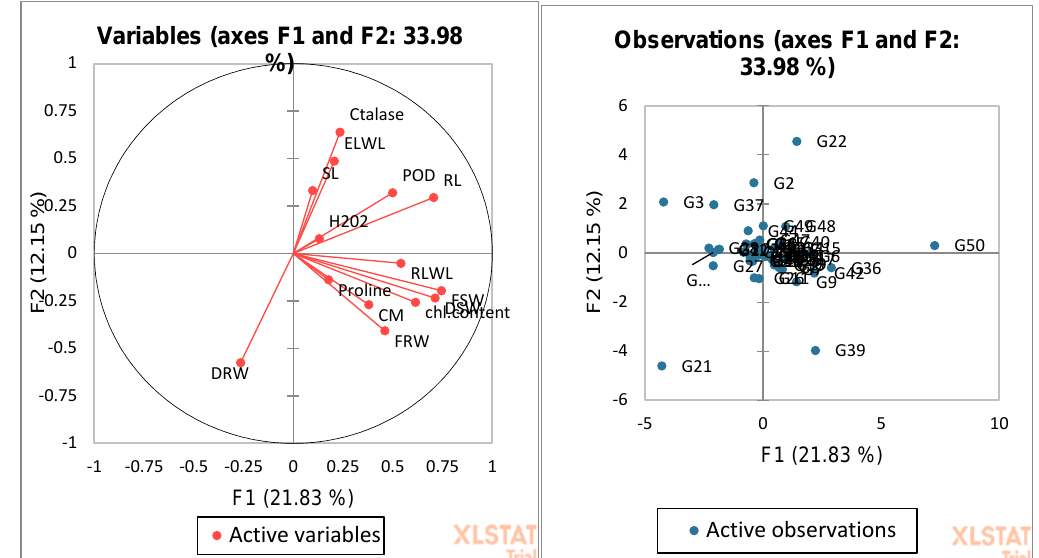
Figure 6. Biplot analysis of 50 cotton accessions for different seedlings characters grown under control level. Where RL = Root length; SL = Shoot length; FRW = Fresh root weight; FSW = Fresh shoot weight; DRW = Dry root weight; ELWL = Excised leaf water loss, RLWL = Relative leaf water loss, CMS = Cell membrane stability, Chlr = Chlorophyll content; Proline = Proline; POD = Peroxidase; H 2 O 2 = Hydrogen peroxide; CAT = catalase activity. Under 75% drought stress cluster analysis of K means had combined these 50 genotypes into five Table 5. K-means cluster analysis of 50 cotton genotypes grown under 75% drought level. clusters. The genotypes in cluster number 3 showed higher average values for root length (10.14 Cluster